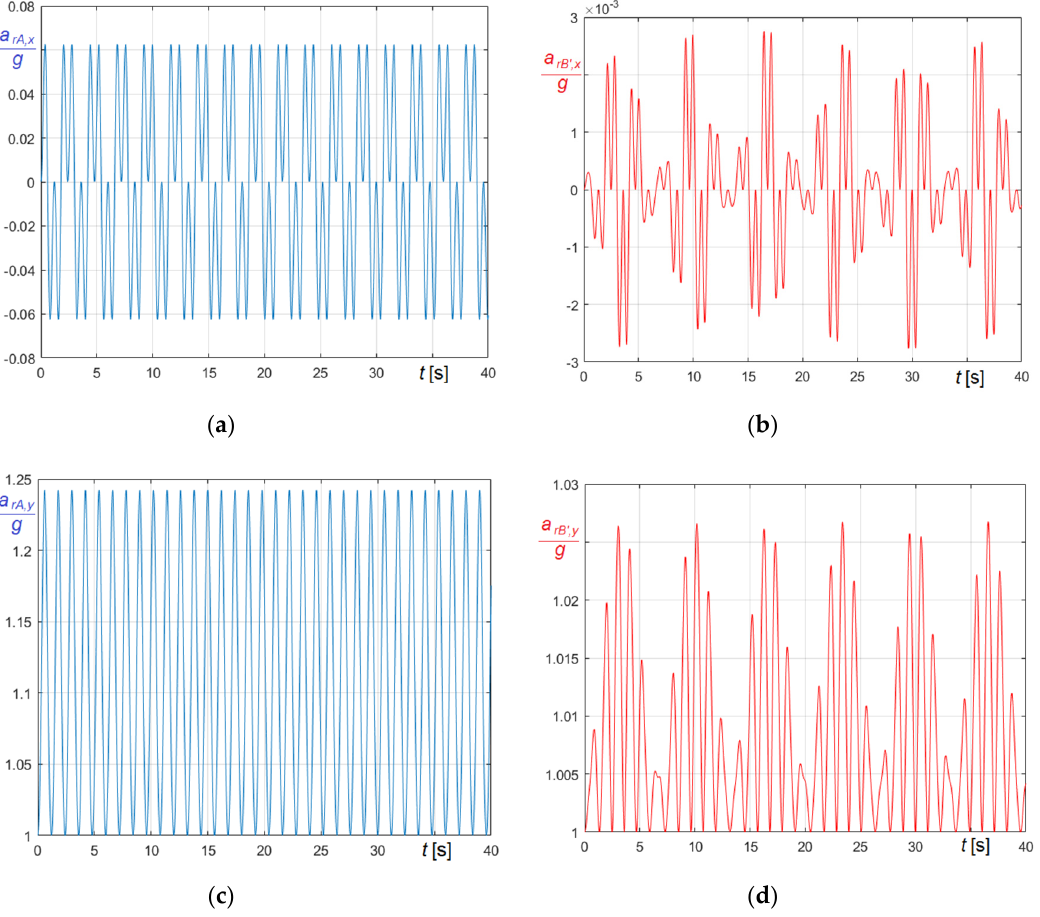
Figure 16. Radial acceleration components at pivots of St. Mary’s tenor bell in case II.b (cid:3435)(cid:1837) = √0.2(cid:3439) : − (cid:1872) curve in (cid:1827) ; ( b ) ( a ) (cid:3028) (cid:3293)(cid:3250),(cid:3299) − t curve in A ; ( b ) a rB (cid:48) , x ( a ) a rA , x (cid:3034) g